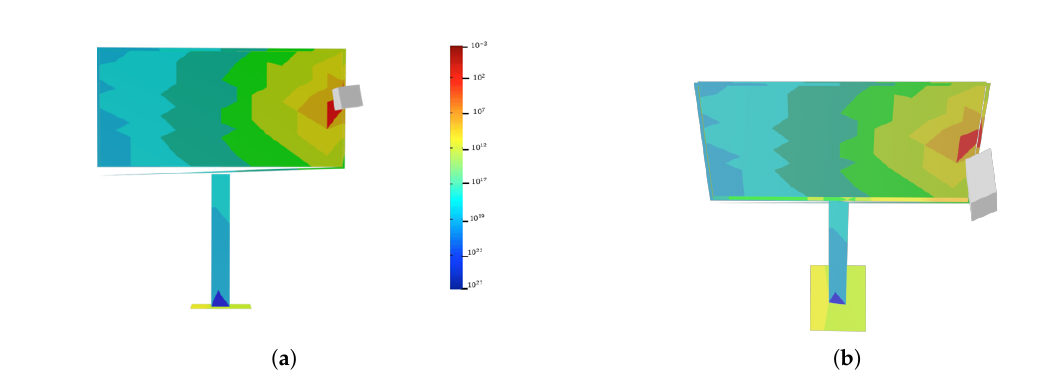
Figure 8. Sample Navigation LOD for a Billboard. ( a ) A square billboard is made of about a hundred triangles and is being observed from a sensor (grey box). The values of L ( φ , d ) are displayed using a log-scale colormap with red representing a high value and dark blue a very small value. ( b ) The billboard from a top viewpoint with the pedestal triangles shown in yellow as cos ( φ ) is close to